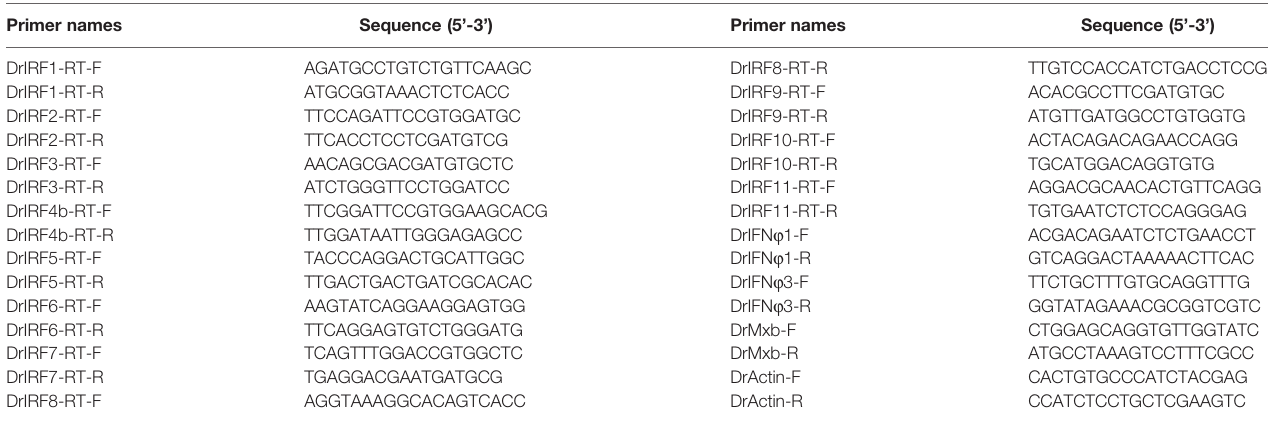
TABLE 1 | Primers used in this